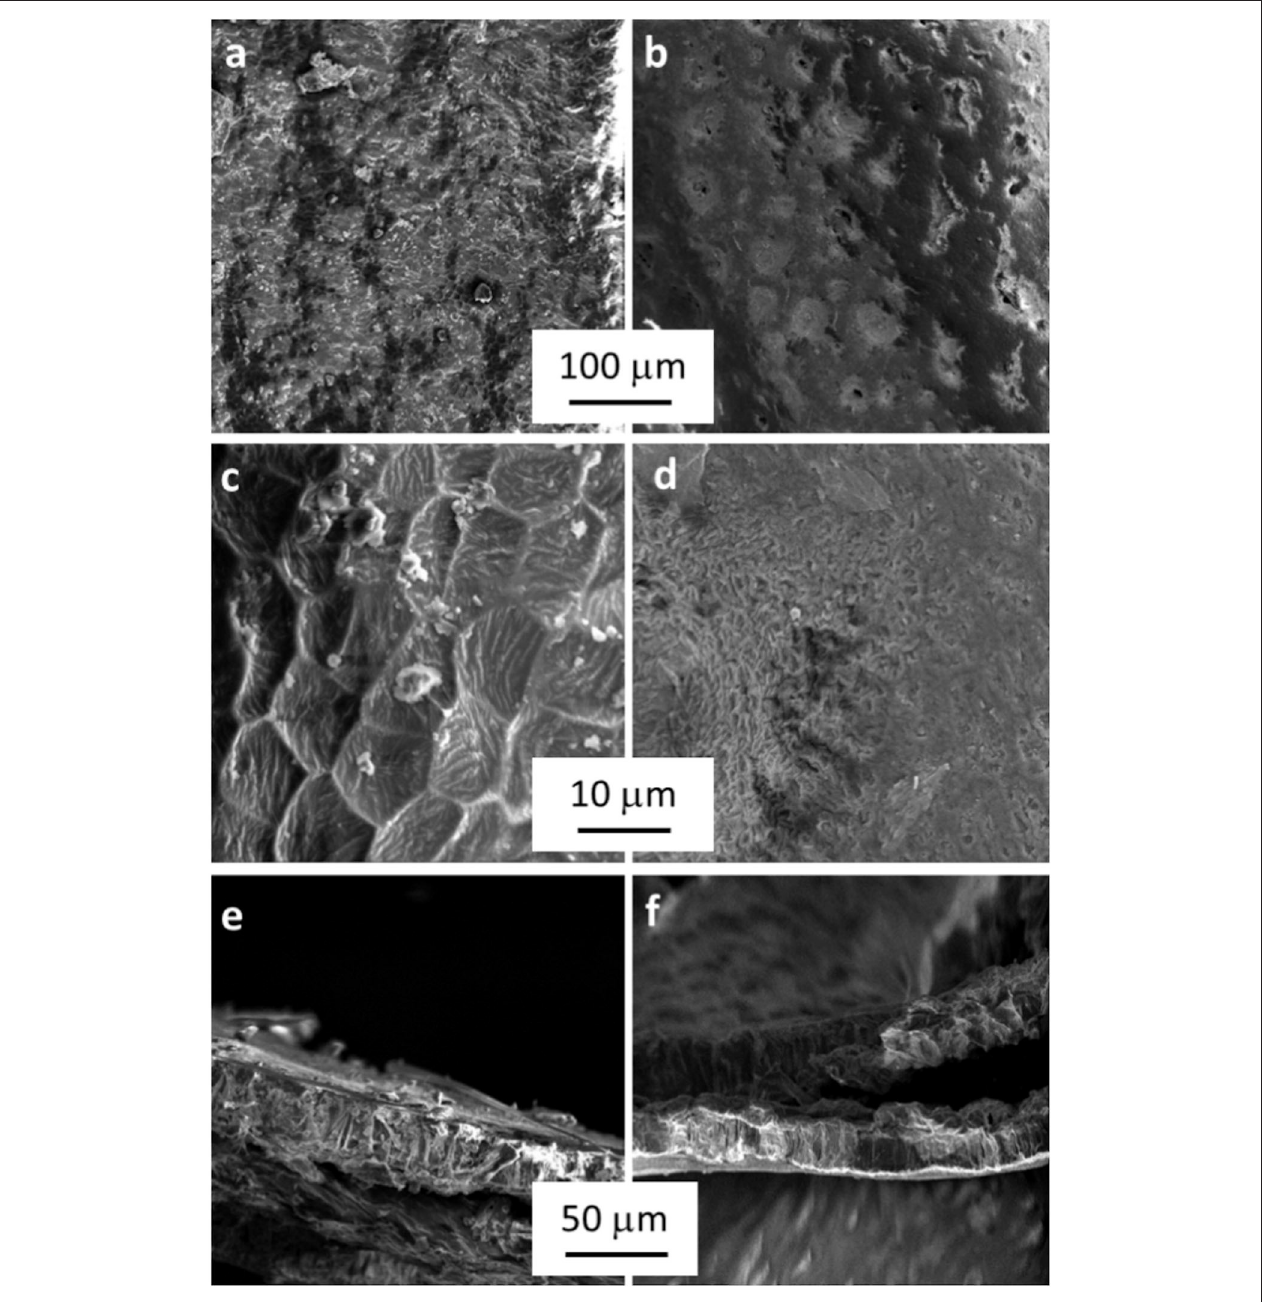
FIGURE 3 | Micrographs of SBH-B (a,c) and SBH-A (b,d) surfaces at different magnifications and, at the bottom, pictures of SBH-B (e) and SBH-A (f) sections.